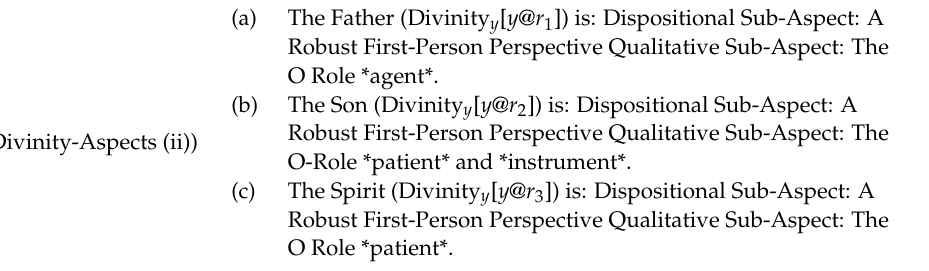
Figure 8. Aspects and Relation Conversions.